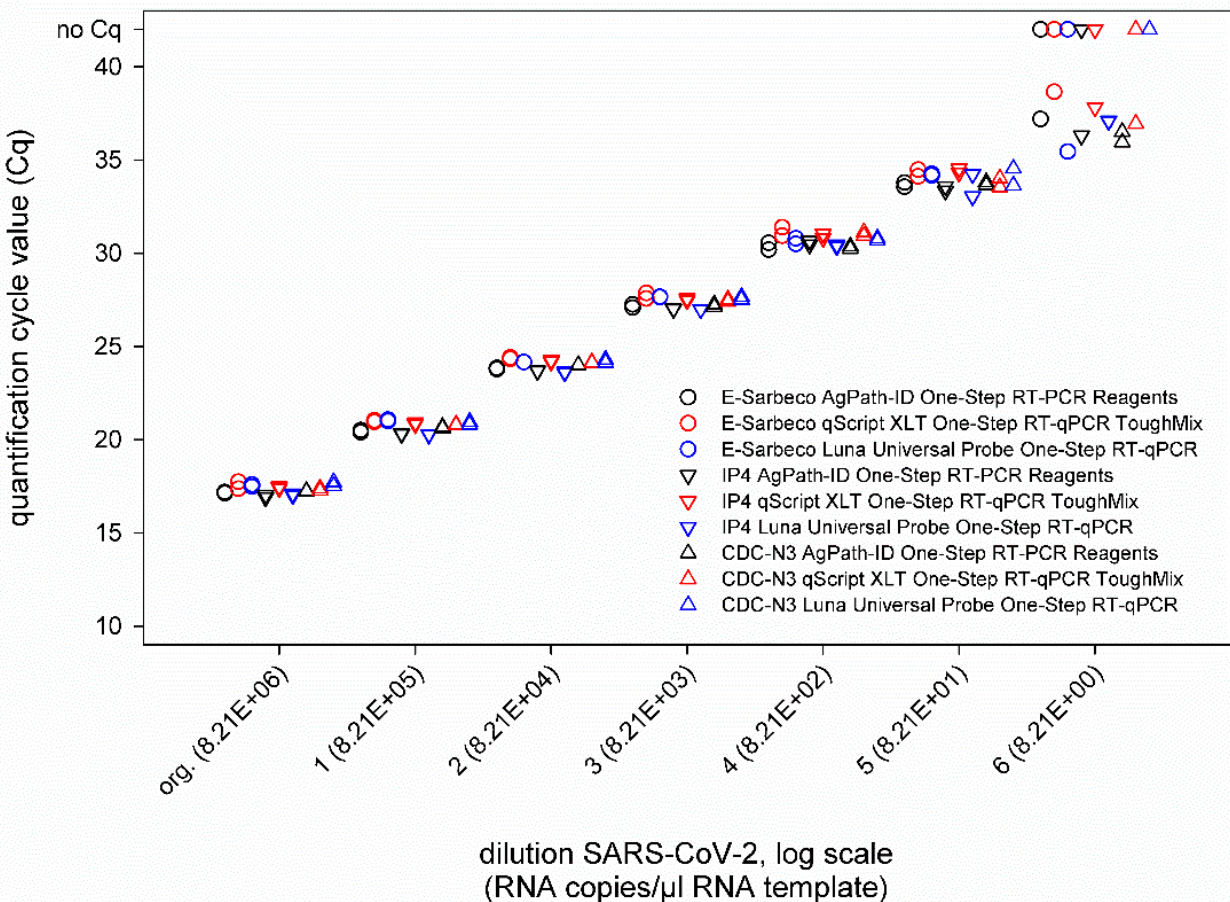
Figure 2. Results of the SARS-CoV-2 real-time RT-PCRs E-Sarbeco, IP4 and CDC-N3 performed in combination with either the AgPath-ID One-Step RT-PCR Reagents kit (black), the qScript XLT One-Step RT-qPCR kit (red), or the Luna Universal Probe One-Step RT-qPCR kit (blue). All samples were tested in duplicate.